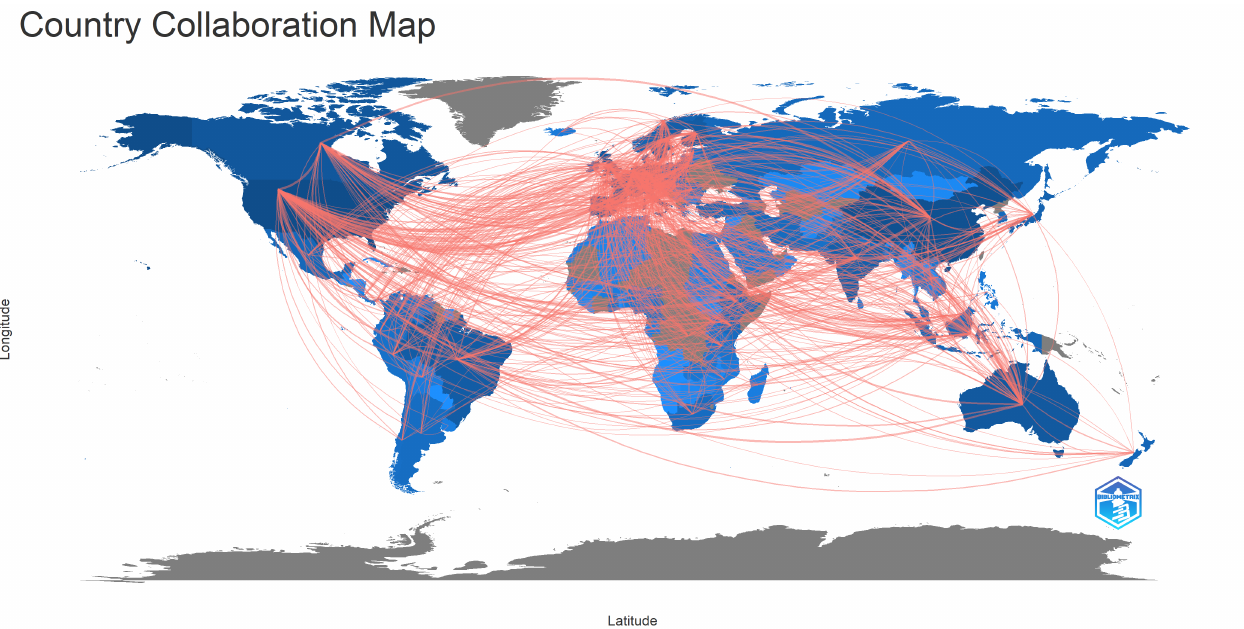
Figure 3. Country collaboration